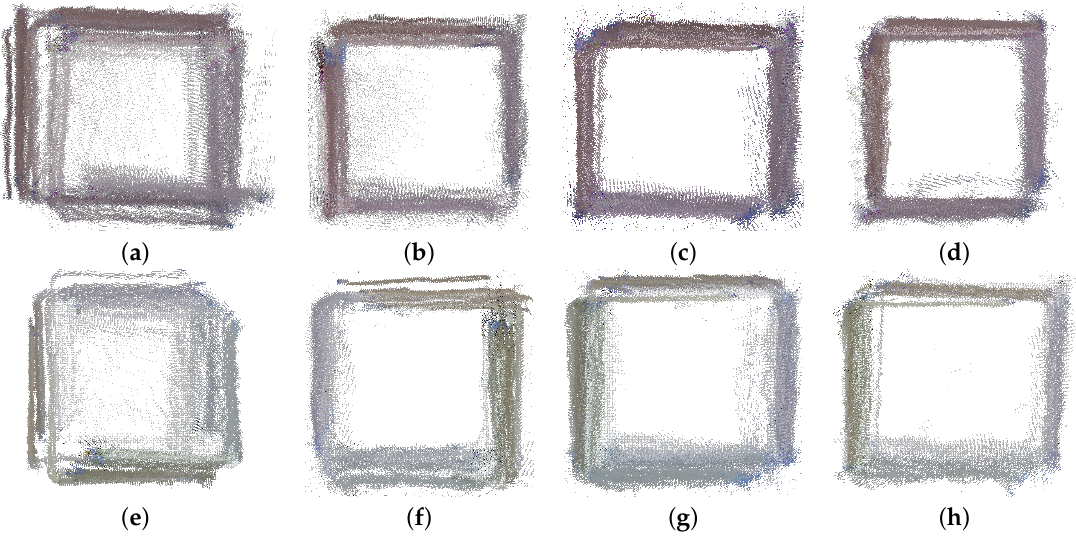
Figure 18. Section of the cube acquired with Kinect v1 in the first row and the Primesense in the second row. The section shows the cube seen from the top. ( a , e ) Default; ( b , f ) Burrus; ( c , g ) Bouguet; ( d , h ) Herrera.